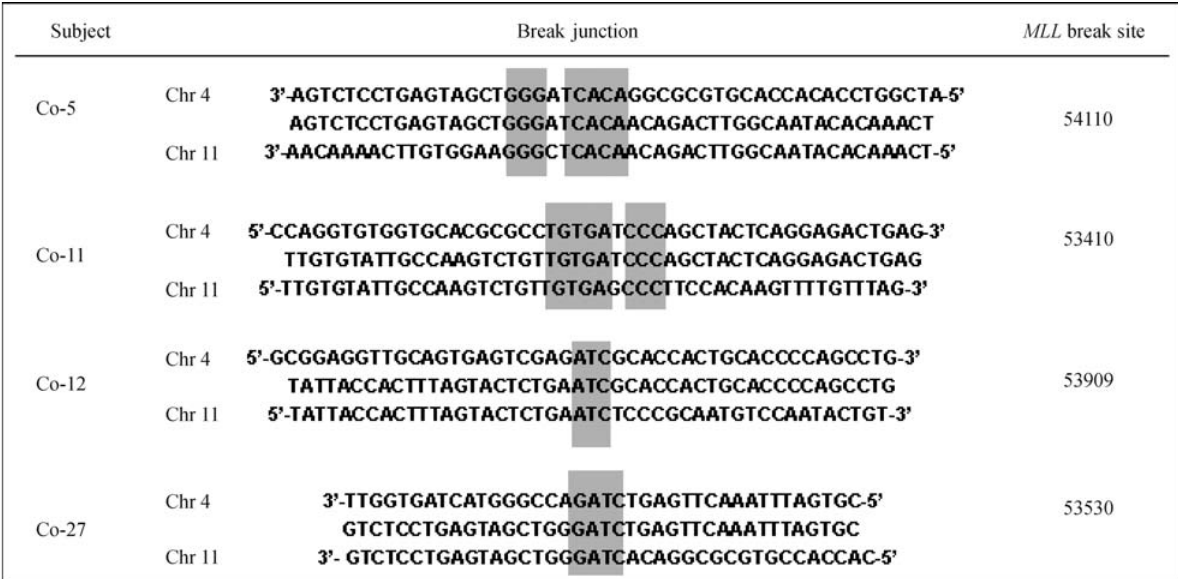
Figure 2 - Illustrative MLL translocations detected by inverse PCR in four subjects. Individual breakpoints are flanked by the germ-line MLL sequence and sequences at chromosome 4. “Break site” refers to the position relative to the MLL gene (GenebankTM accession number Y373585) fused to its part- ner. Grey boxes indicate short microhomologies between MLL and AF4